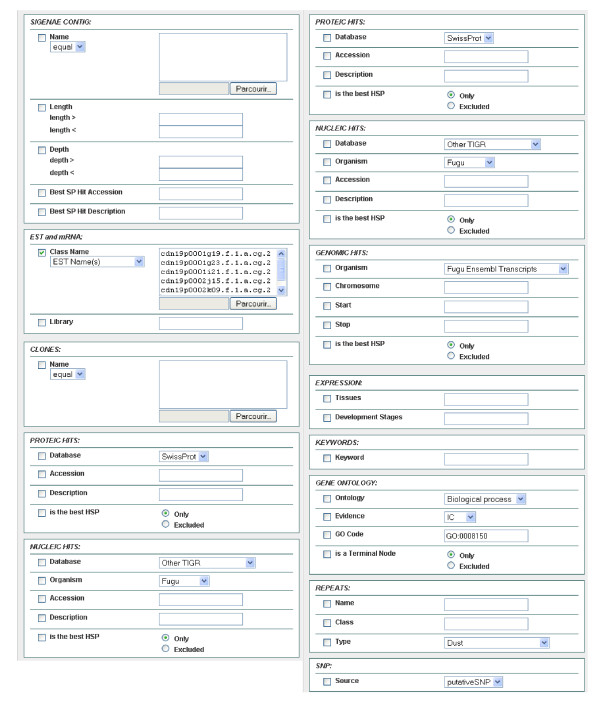
Filter page available with BioMart in GigasDatabase. Filter criteria are deposited in blocks. The name is in the upper left corner of the block, and this section contains a list of elements that can be used for selection, corresponding to one table in the database structure. The filter criteria can be based upon contigs, EST and mRNA, clones, protein hits, nucleotide hits, genomic hits, expression, keywords, gene ontology, repeats, and SNP.